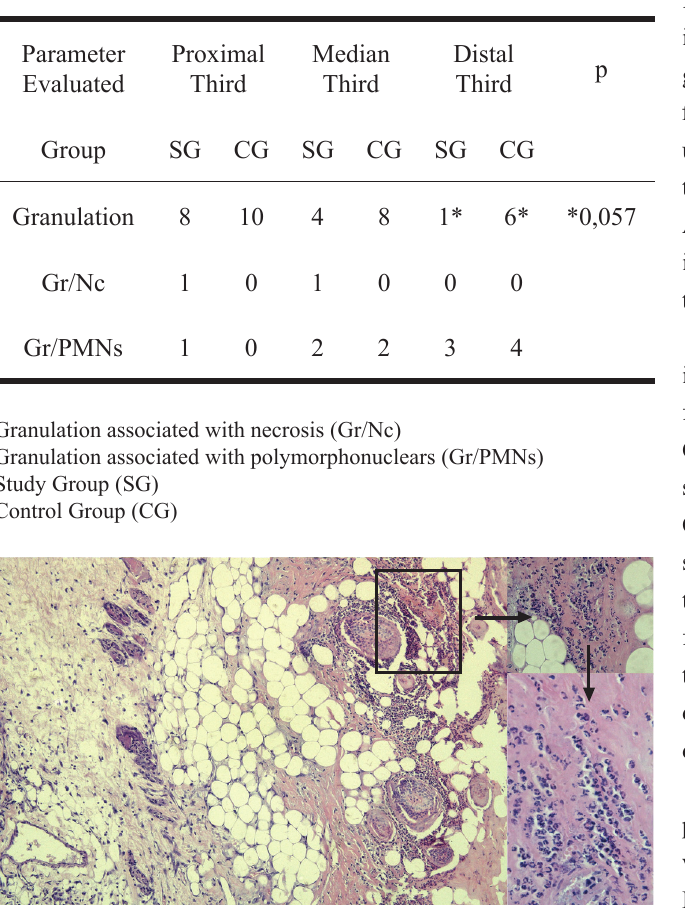
TABLE 2 - Absolute number of granulation cases, granulation associated with necrosis or granulation associated with polymorphonuclears in biopsies collected on the seventh postoperative day, on the proximal, medium and distal thirds of the McFarlane flap, after sildenafil injection (Study Group) or saline solution (Control Group) subdermally.